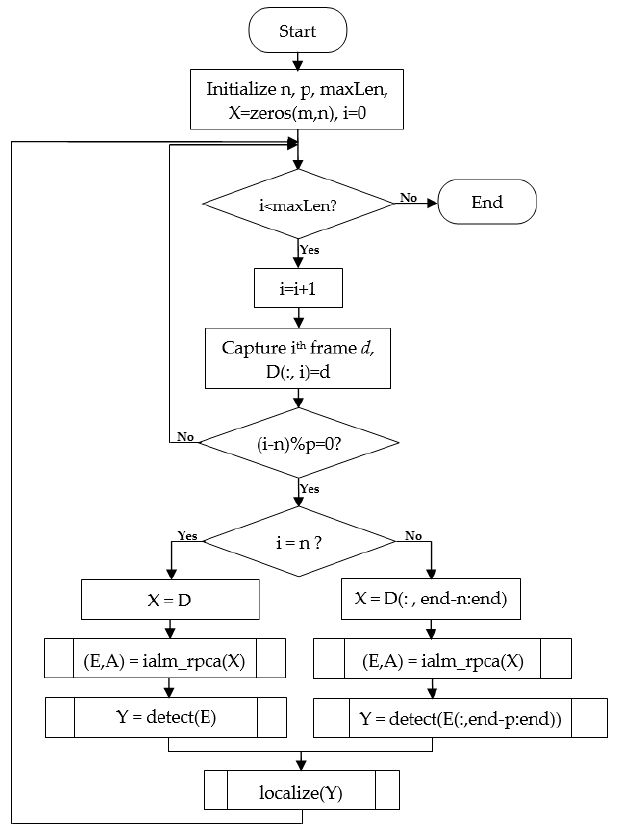
Figure 6. Overlapping windows method flowchart.